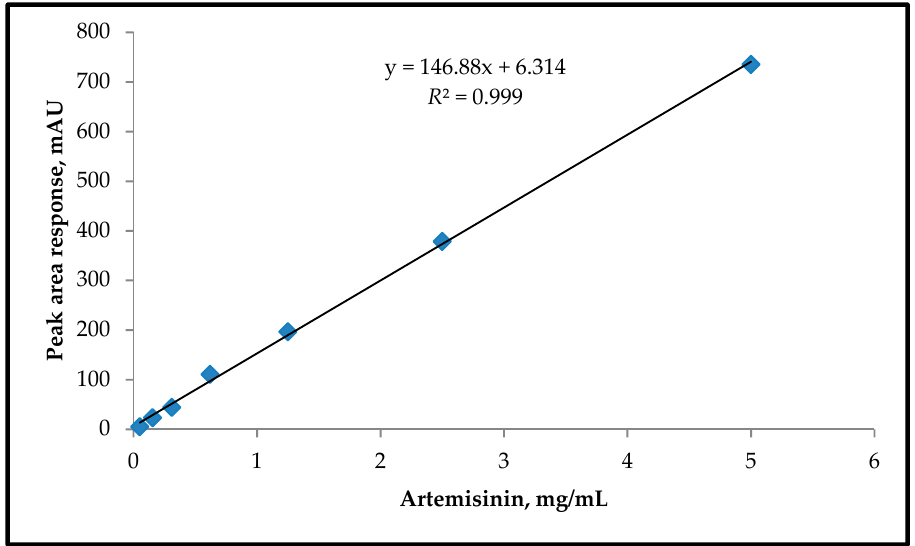
Figure 2. Linear calibration graph for the standard artemisinin.